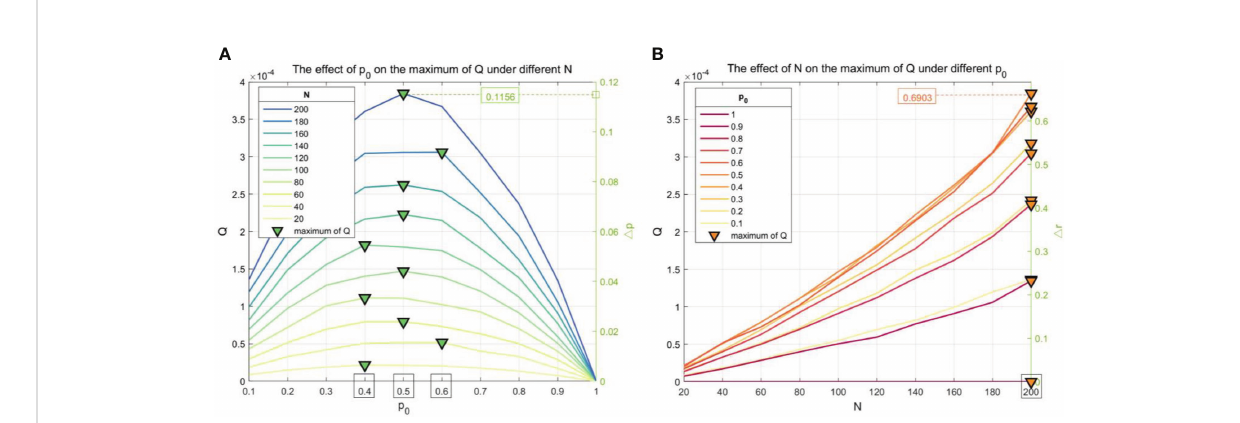
FIGURE 18 The curves of Q varying with p 0 and N . (A) The effect of p 0 on the maximum of Q under different N. (B) The effect of N on the maximum of Q under different p 0.